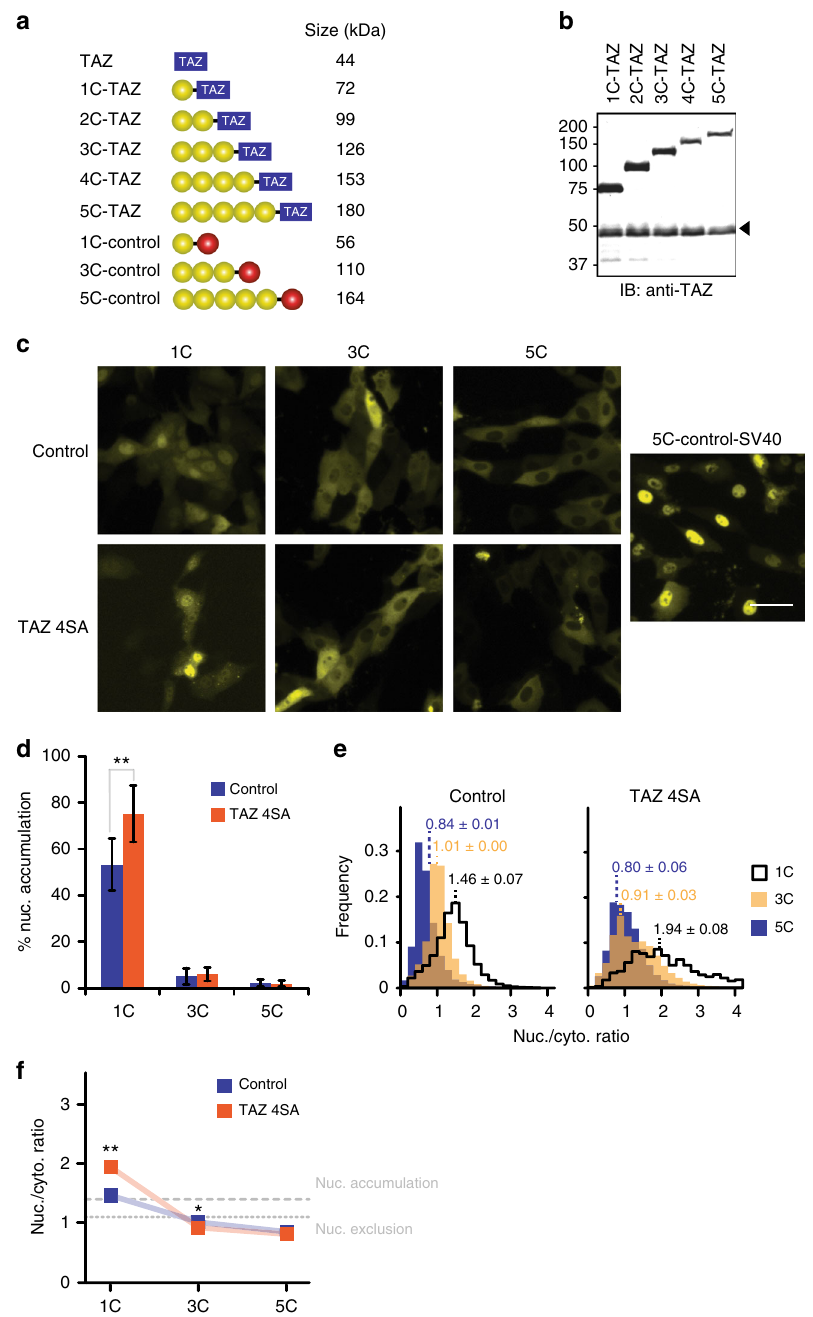
Fig. 1 Large tags suppress nuclear accumulation of TAZ under steady-state conditions. a TAZ and a control (mCherry, red circle) were fused to increasing numbers of mCitrine molecules (yellow circles). Molecular weights are indicated. b Western blot analysis of transiently over-expressed TAZ constructs in LLC-PK1 cells, using a TAZ-speci fi c antibody. Endogenous TAZ is marked by an arrowhead. An uncropped version is shown in Supplementary Figure 1A. c Fluorescence microscopy images of LLC-PK1 cells transiently expressing control or TAZ 4SA constructs with varying tag-sizes (numbers of mCitrine units). 5C-control-SV40 additionally comprises residues 114 – 135 of simian virus 40 (SV40) large tumor antigen that mediate strong nuclear import. This construct demonstrates that the 5C-tag does not abolish mediated import and serves as positive control for nuclear localization. Images depict mCitrine fl uorescence. Scale bar represents 50 μ m. Representative images of one experiment. Number of repeats: n = 3. d Visual quanti fi cation of cells with nuclear enrichment of control and TAZ 4SA constructs. Cells were scored as “ nuclear ” (nuc.) if nuclear fl uorescence was visibly higher than cytoplasmic fl